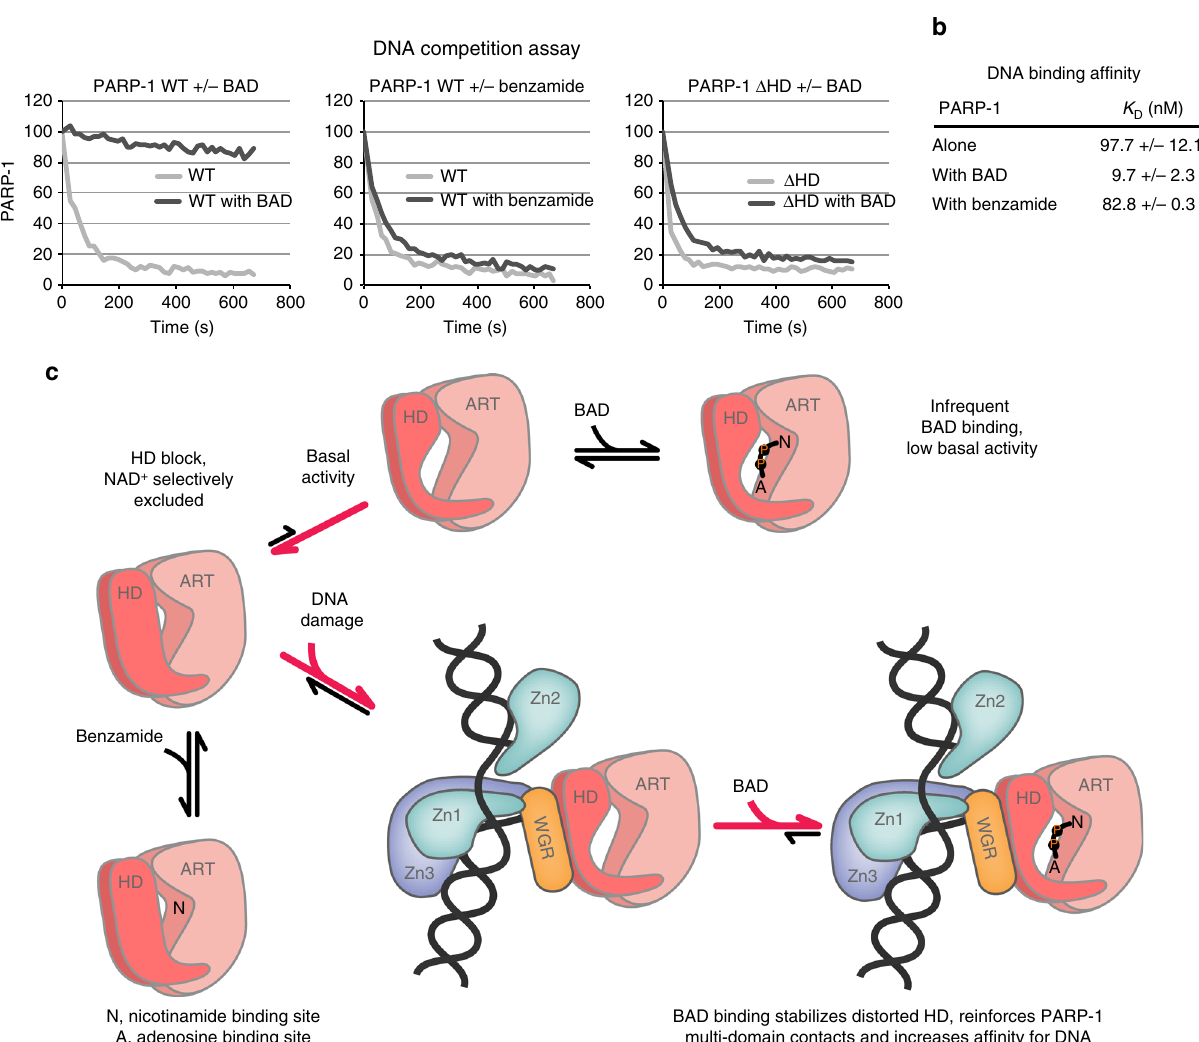
N, nicotinamide binding site A, adenosine binding site Fig. 6 Allosteric coupling of PARP-1 catalytic active site and DNA-binding domains and model for the mechanism of HD regulation. a The fl uorescence polarization DNA competition assay was performed by incubating 40 nM of PARP-1 WT or PARP-1 Δ HD with 20 nM of fl uorescently labeled DNA (dumbbell DNA containing a central nick and an internal fl uorescent FAM group) in the absence or presence of BAD or benzamide at 500 μ M. A competitor unlabeled DNA was added and FP was measured over time. A representative experiment is shown. b PARP-1 af fi nity for DNA in the presence or absence of the indicated compounds, as measured by fl uorescence polarization (see also Supplementary Fig. 9). c In its native state, the HD primarily exists in a folded conformation that selectively restricts access to the NAD + -binding site, which can be subdivided into the nicotinamide binding site (N) and the adenosine binding site (A). Small molecules such as benzamide can access the NAD + -binding site in the closed HD state, but BAD and NAD + binding is completely blocked in the folded state of the HD. The inherent dynamics of the HD sample the open conformation infrequently, leading to the basal level of PARP-1 catalytic output. The DNA-damage-dependent regulatory domains of PARP-1 form an interface with the HD that promotes an open, unfolded HD conformation that allows NAD + to have access to the active site. BAD binding to the catalytic active site shifts the HD equilibrium distribution to the unfolded state, thereby promoting the multi-domain contacts of PARP-1 with damage DNA, and increasing PARP-1 af fi nity for DNA (see panels a and b